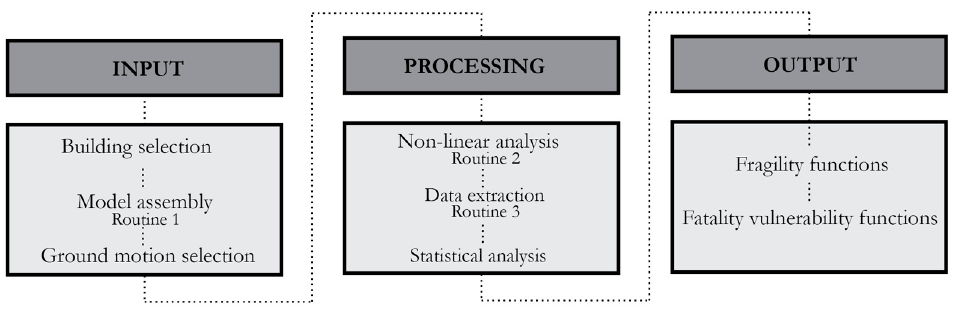
Figure 7. Framework for vulnerability assessment of adobe buildings.